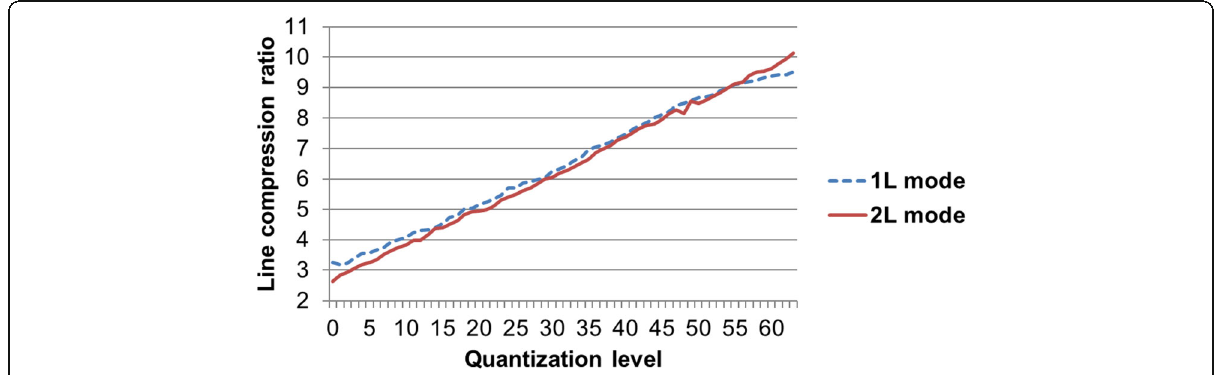
Fig. 9 Differences in BRC table characteristics according to 1L and 2L